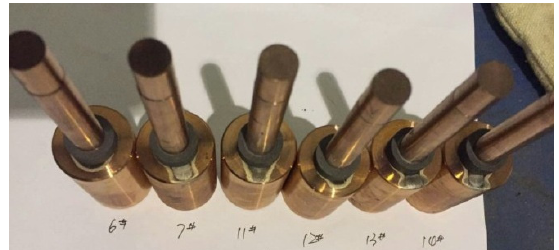
Figure 15. The brazed samples with side solder feeding. Table 3. The shear strength for the samples brazed with side solder feeding.